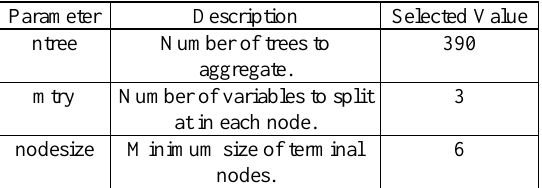
Table 1 . Values for tuned hyperparameters for RF model using a grid search approach and combination of LiDAR, optic, and SAR